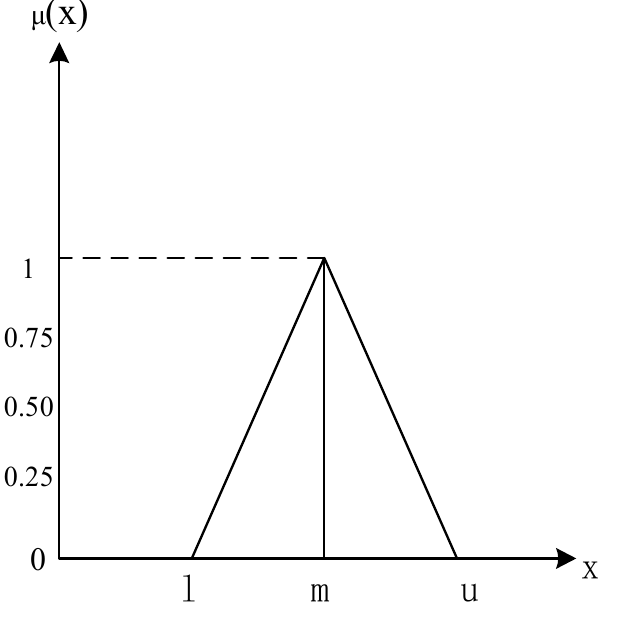
Figure 2. Triangular fuzzy number. Table 2. Correspondence between the linguistic terms and triangular fuzzy